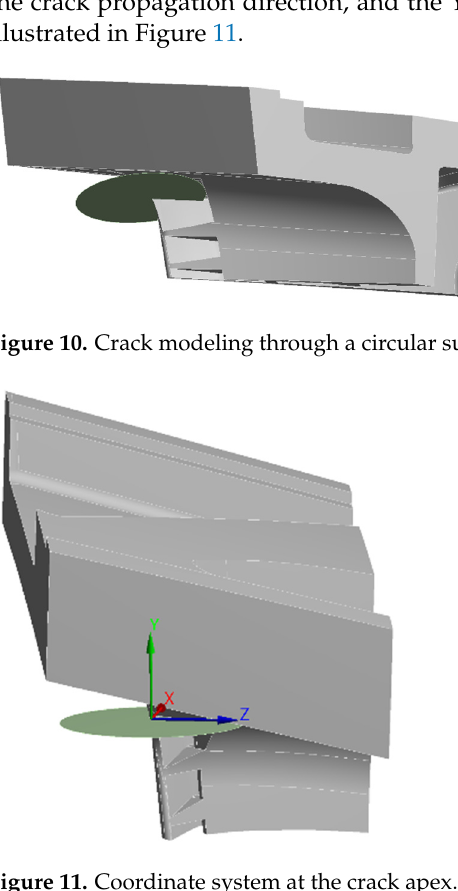
8 of 25 Figure 8. SOLID 187 geometry. ( a ) ( b ) Figure 9. Mesh results: ( a ) refined mesh on sub-model; ( b ) mesh result around the PETE due to the sphere of influence. 2.2.3. Crack Modeling Among the several techniques employed to simulate fracture behavior of complex structures, the finite element method (FEM) is largely adopted. This work used the Fracture Tool within ANSYS Mechanical Workbench, in particular the Arbitrary Crack Method ,